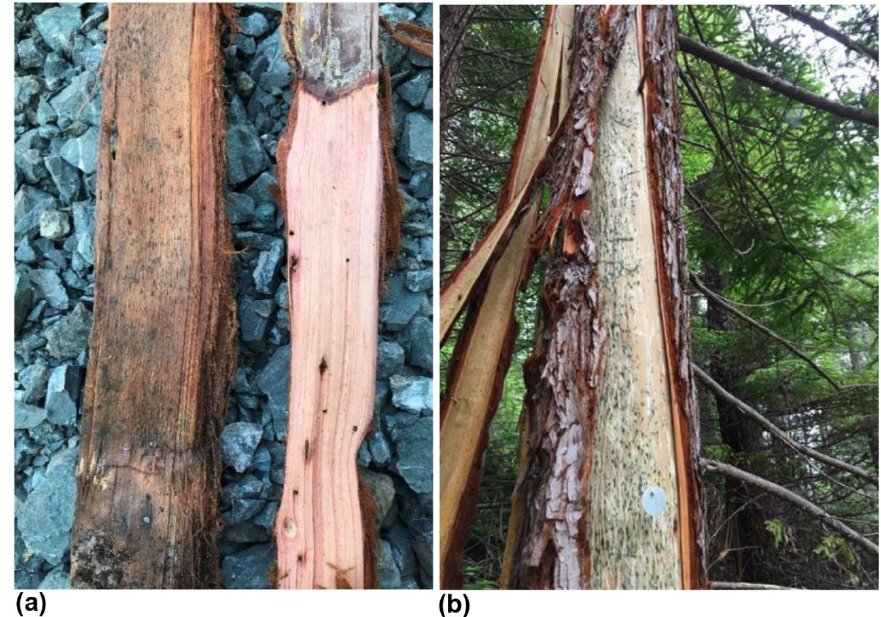
Figure 4. An example of characteristics used to determine fresh damaged observed in the field: ( a ) A photo of bark from old damage (left) and fresh damage (right); ( b ) A tagged redwood tree with fresh damage.